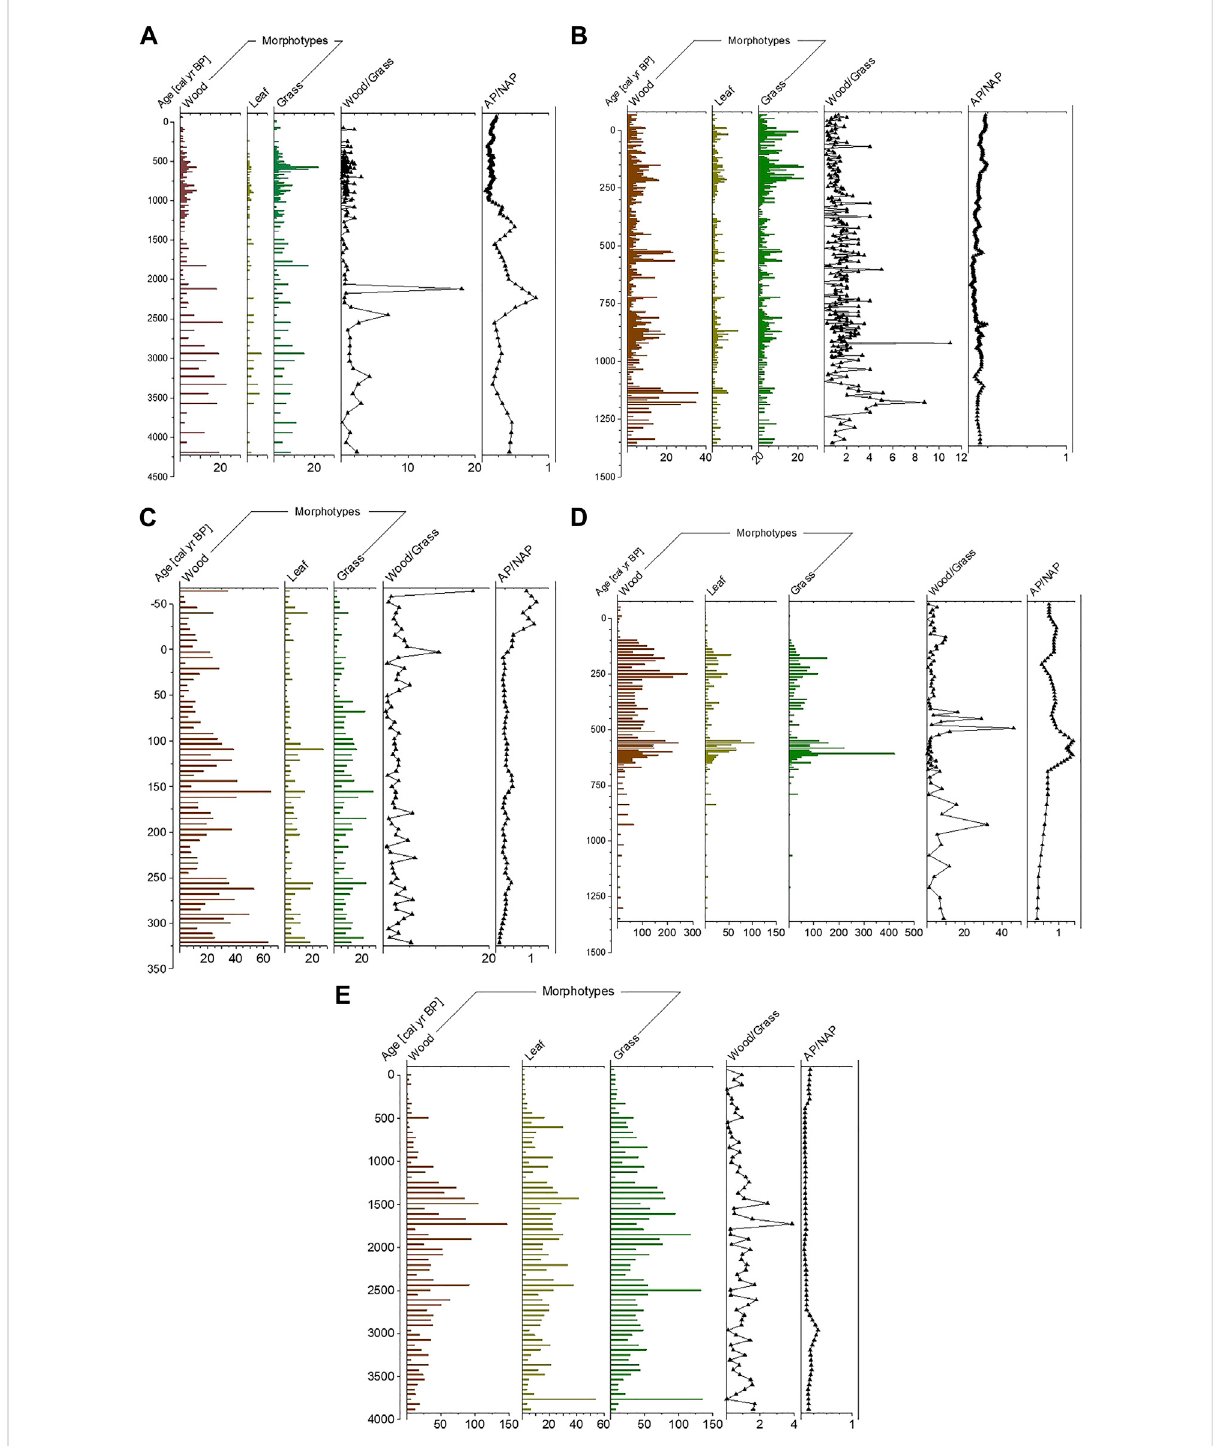
FIGURE 5 Macro-charcoal morphotypes (total counts per sample), wood/grass morphotype ratios, and AP/NAP ratios: (A) Site D3L6; charcoal and pollen data from Unkelbach et al. (2019), (B) site D1L1; charcoal and pollen data from Unkelbach et al. (2020), (C) site Ch; charcoal and pollen data from Unkelbach et al. (2021a), (D) site Tr5-2B; charcoal and pollen data from Unkelbach et al. (2021a), and (E) site G2-A; charcoal and pollen data from Unkelbach et al.